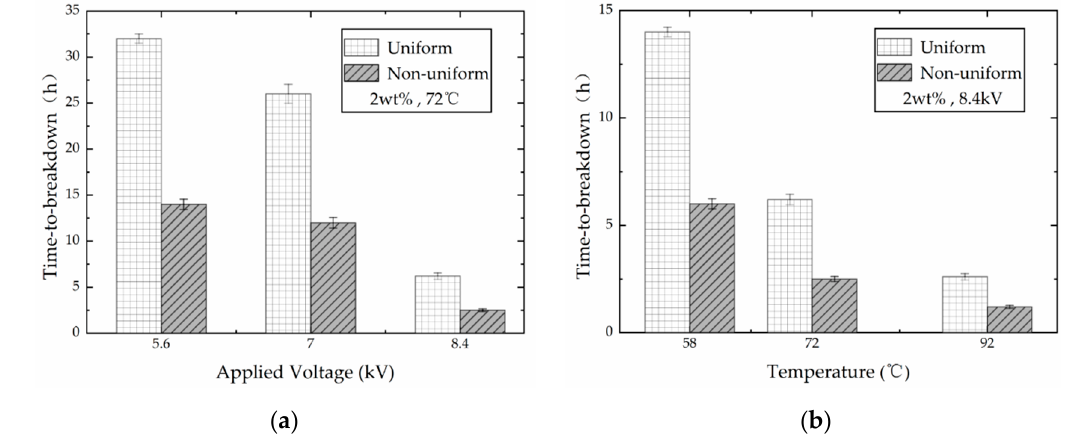
Figure 6. Time-to-breakdown of PP films filled with 2 wt % nano-clay between uniform and non-uniform electric field under DC voltages. ( a ) Results at 72 °C; ( b ) results at 8.4 kV.